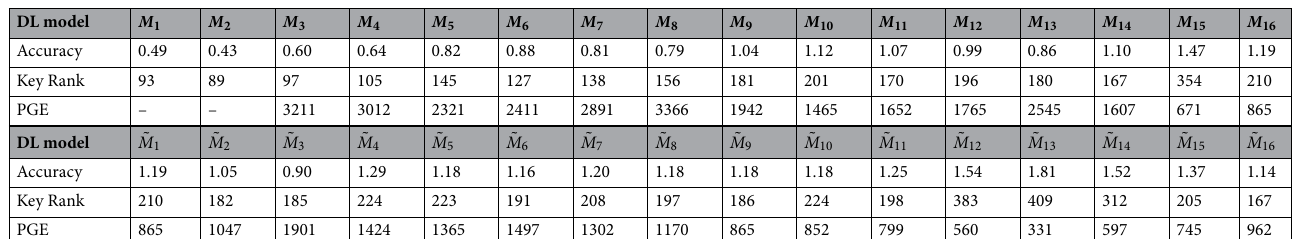
˜ M i on the testing set S 16